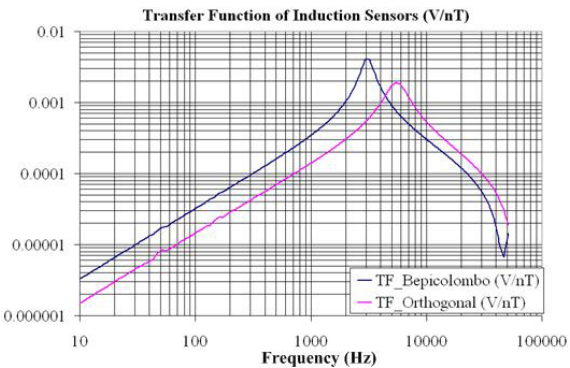
Figure 6. Transfer function of the orthogonal induction sensor (pink curve) versus that of the BepiColombo sensor (blue